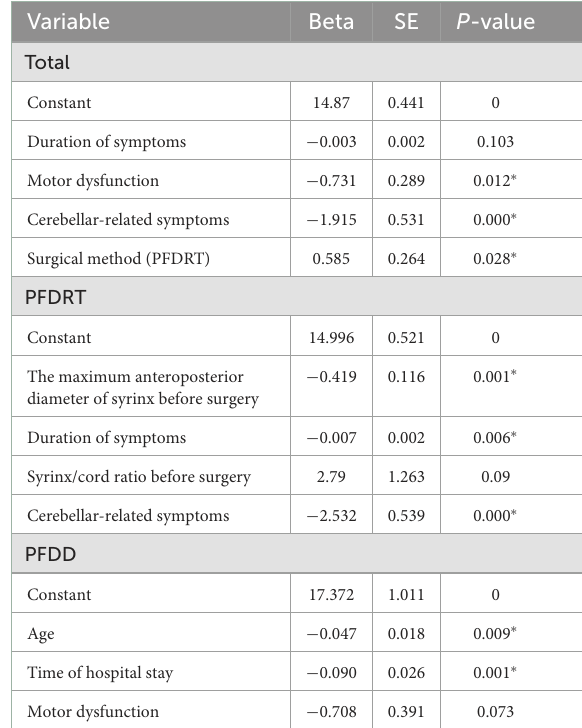
TABLE 4 CCOS multiple regression